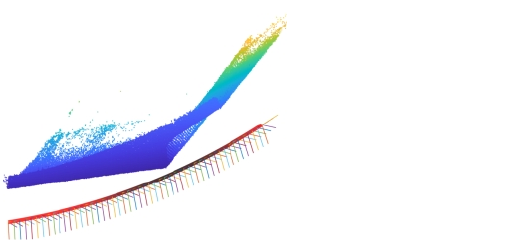
Figure 13. All the tool paths.